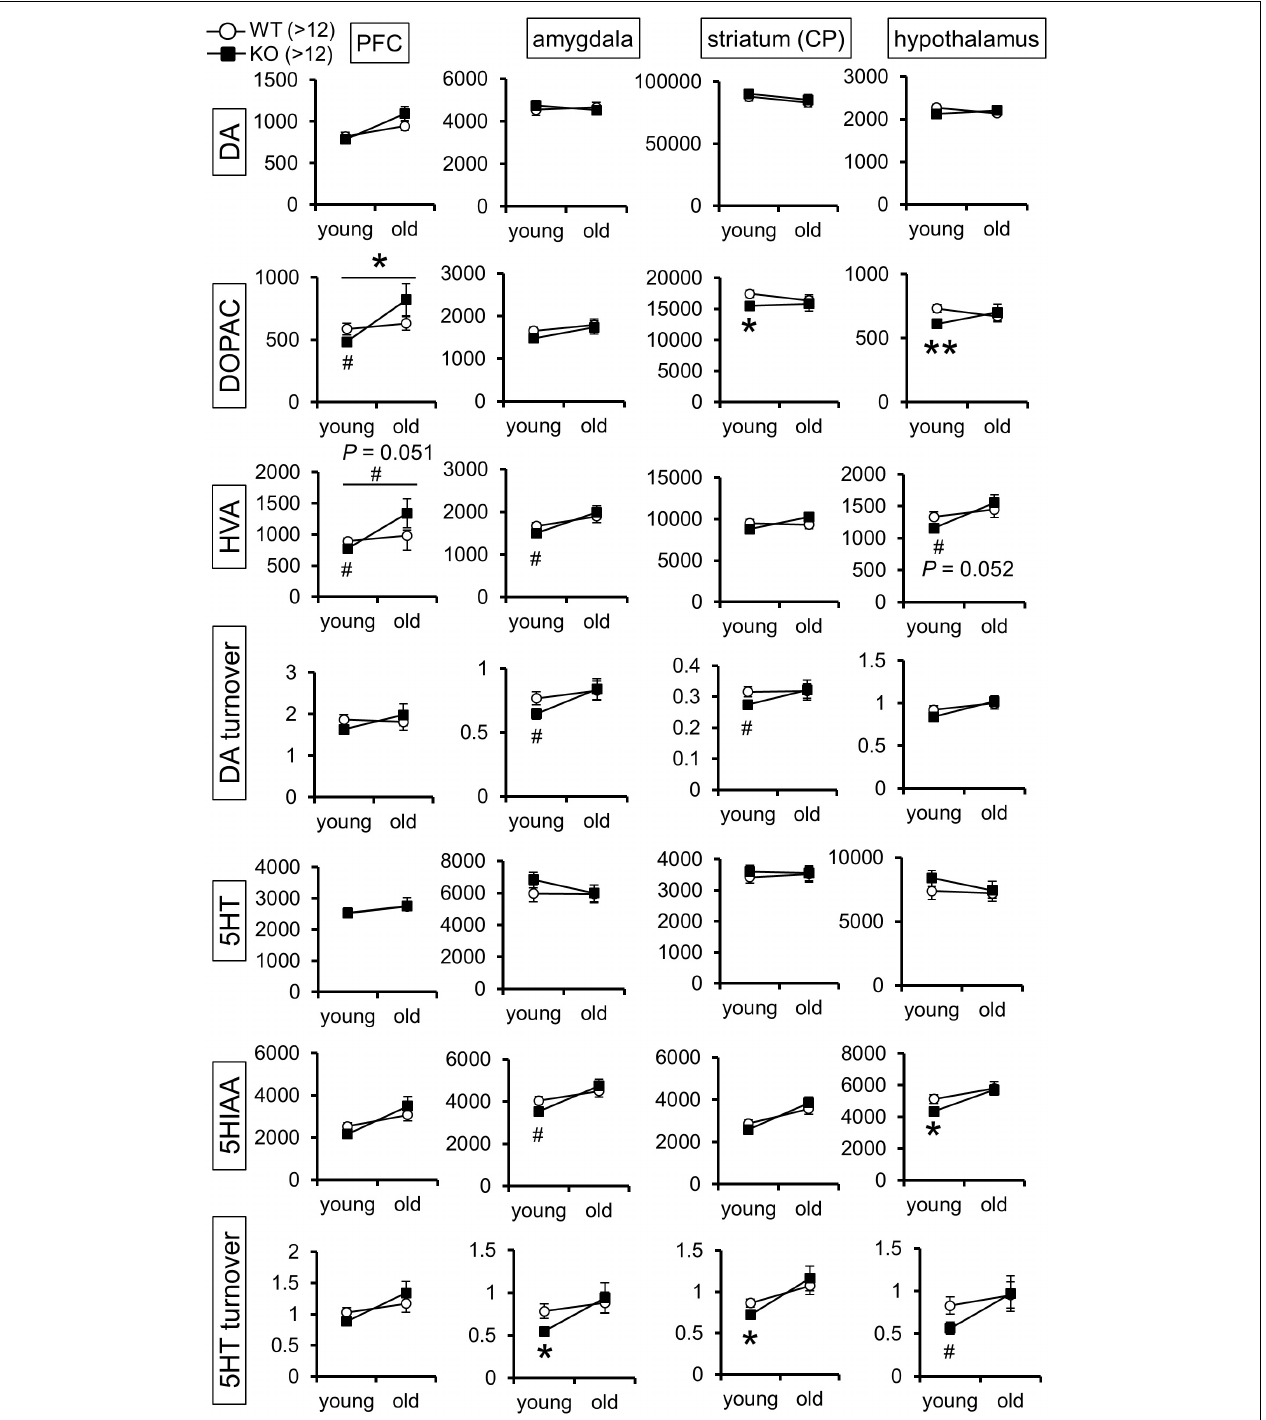
FIGURE 6 | Monoamine content is altered in the brain of Lrtm2 KO mice. Graphs indicate mean monoamine concentration values (pg/mg protein; white circle , WT; black square , KO) for 5-month-old (young) and 13–20-month-old (old) mice, n = 13 (WT, young), 14 (KO, young), 13 (WT, old), or 13 (KO, old) mice for each group. Error bars, standard error of the mean (SEM). # p < 0.1; * p < 0.05; ** p < 0.01 in Student’s t -test. Top horizontal bars in PFC-DOPAC and PFC-HVA graphs indicate #, p < 0.1; * p < 0.05, two-way ANOVA (p genotype × age ). HVA, homovanillic acid; 5HIAA, 5-hydroxy indole acetic acid. The results for hippocampus, noradrenaline, and its metabolites are indicated in Supplementary Figure 5